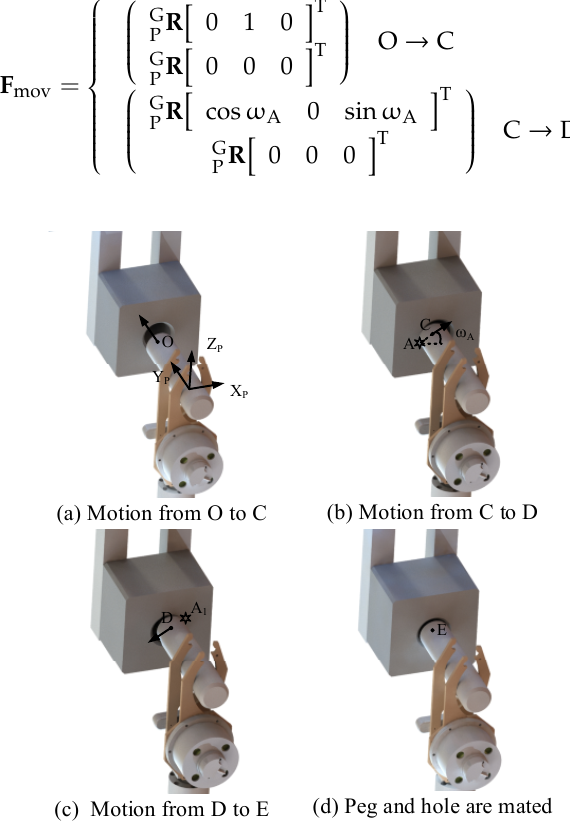
Figure 9. The movement of the peg when the peg contacts the chamfer of the hole.